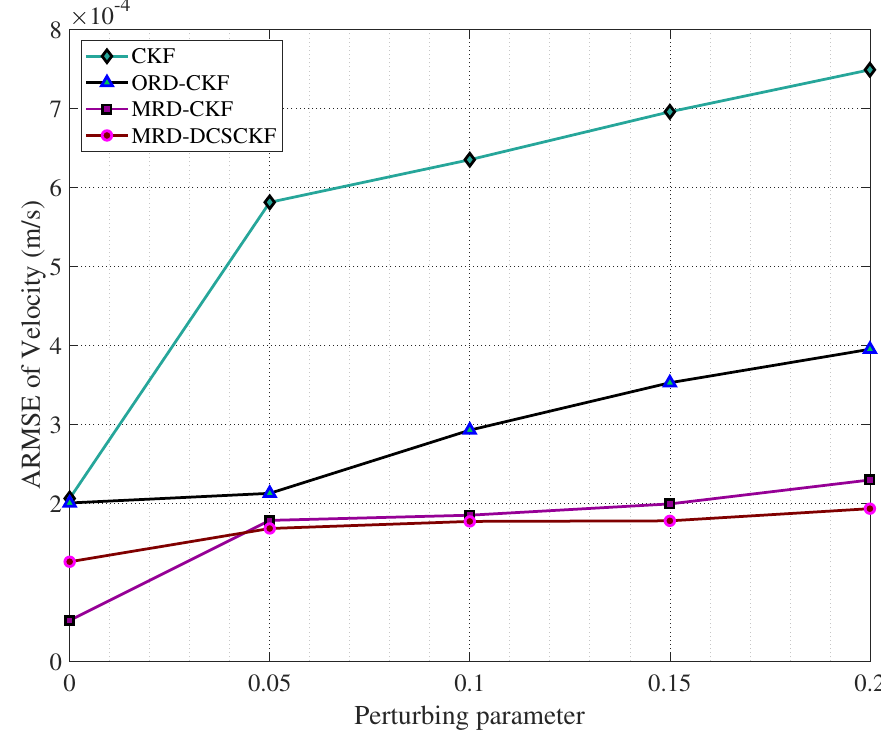
Figure 21. ARMSEs of velocity under different perturbing